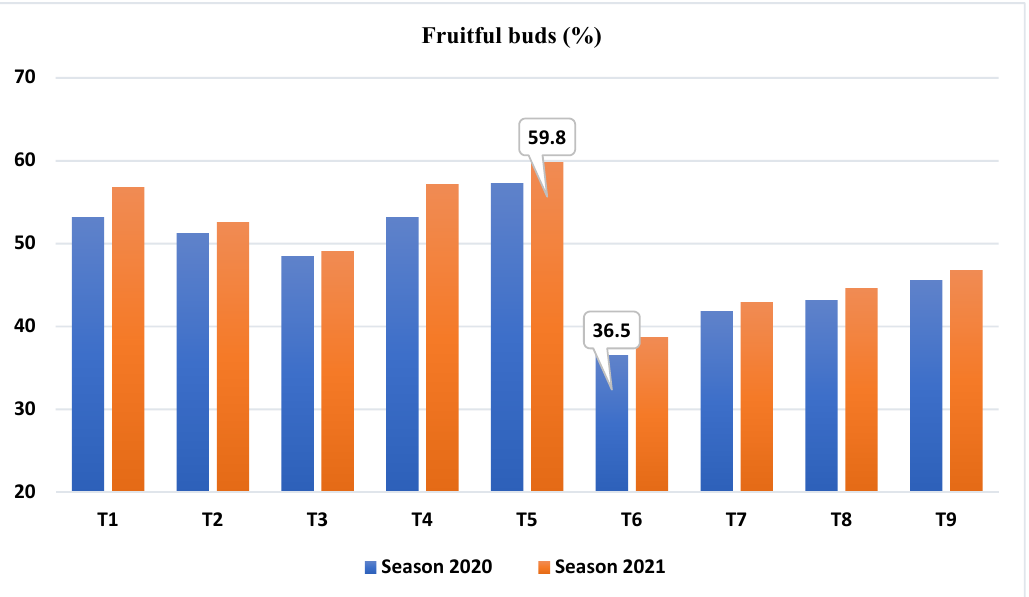
Figure 3. Effect of mineral fertilizer alone or combined with superabsorbent polymers (SAPs) on fruitful buds (%) of Autumn Royal grapevines in 2020 and 2021 seasons.